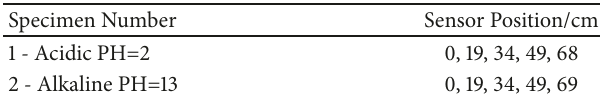
Table 2: FBG sensor